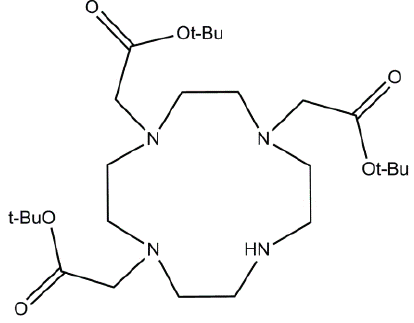
Figure 8. Chemical structure of Product 4